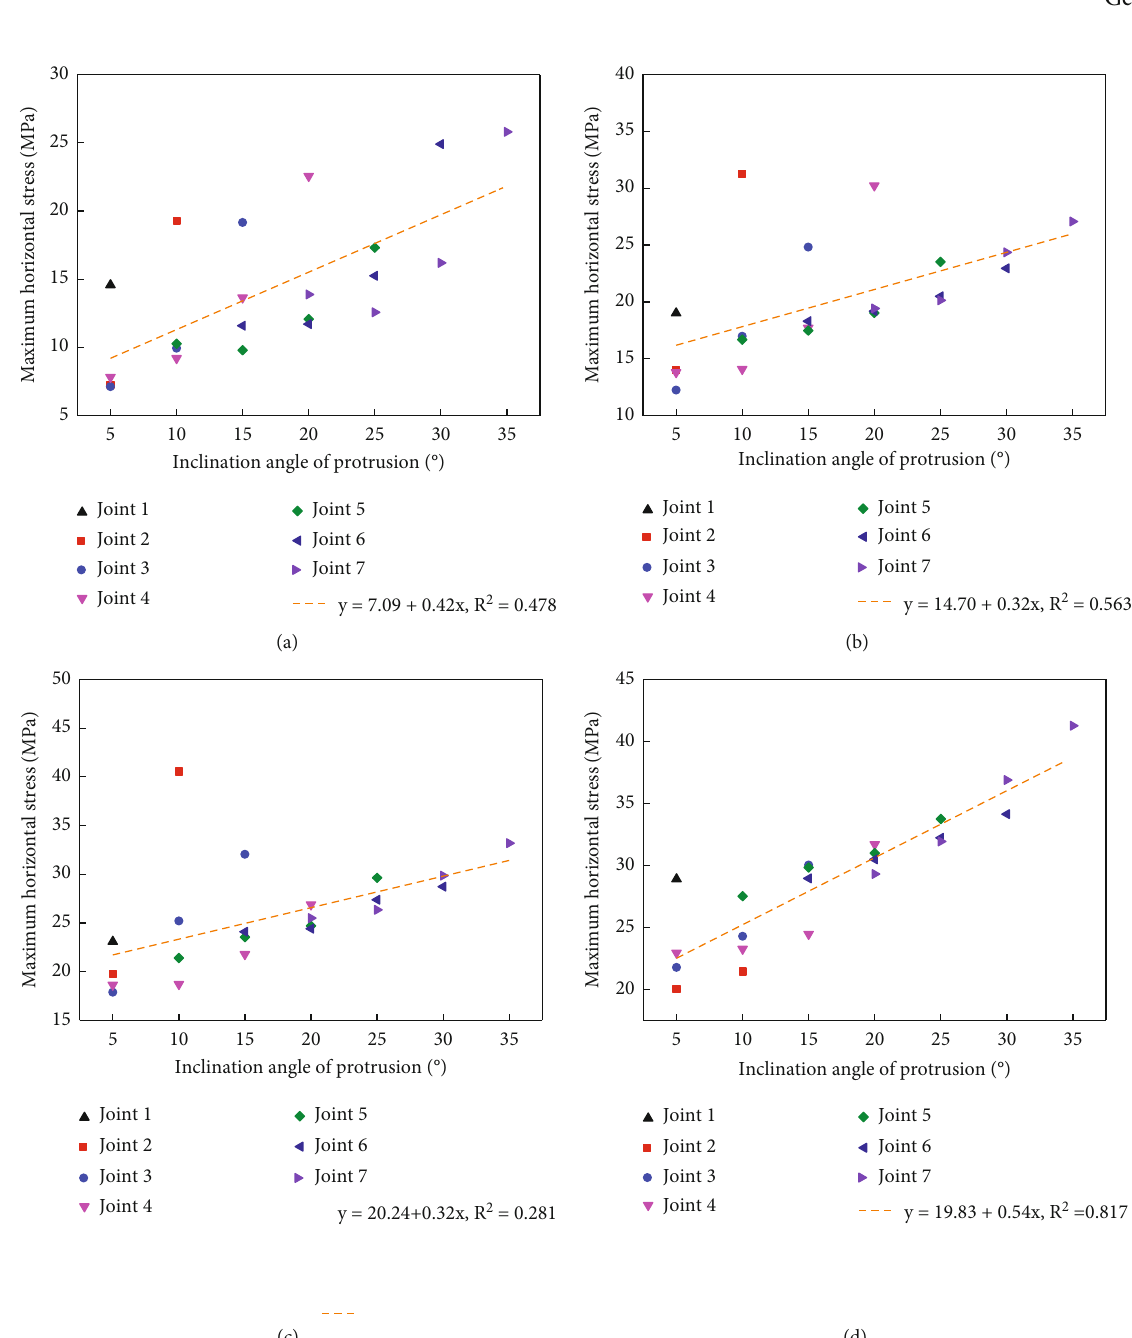
Figure 18: The relationship between inclination angle of protrusion and maximum horizontal stress: (a) 2MPa; (b) 4MPa; (c) 6MPa; (d)